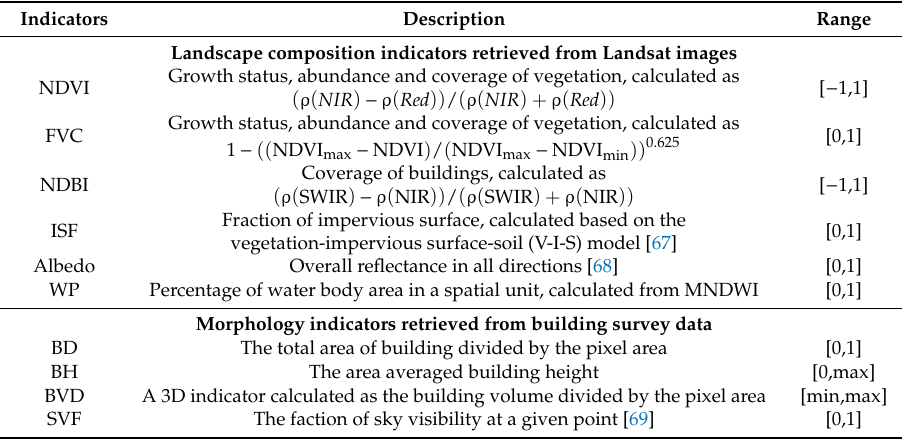
Table 1. Comprehensive information about the selected